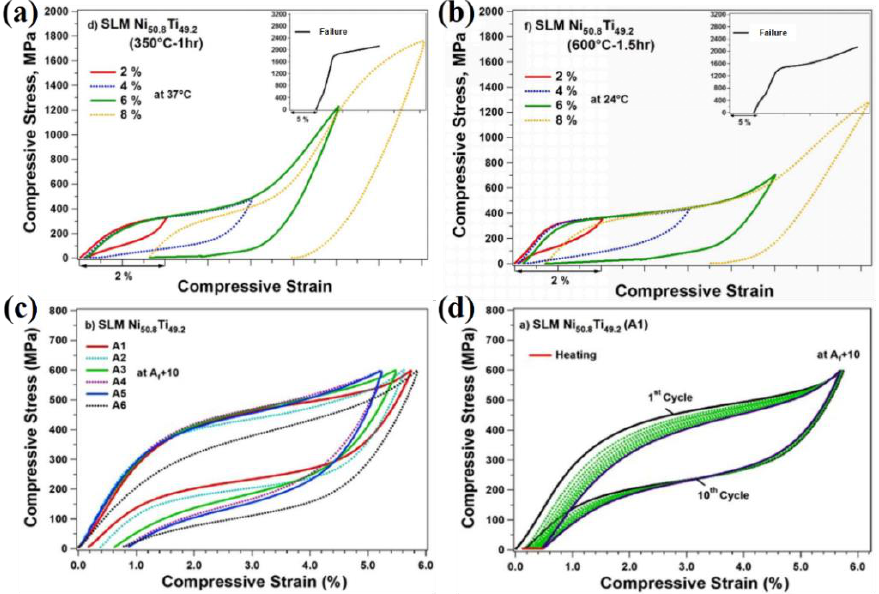
Figure 10. ( a ) Stress-strain curve of Ni-Ti alloys at 350 °C−1 h; ( b ) stress-strain curve of Ni-Ti alloys